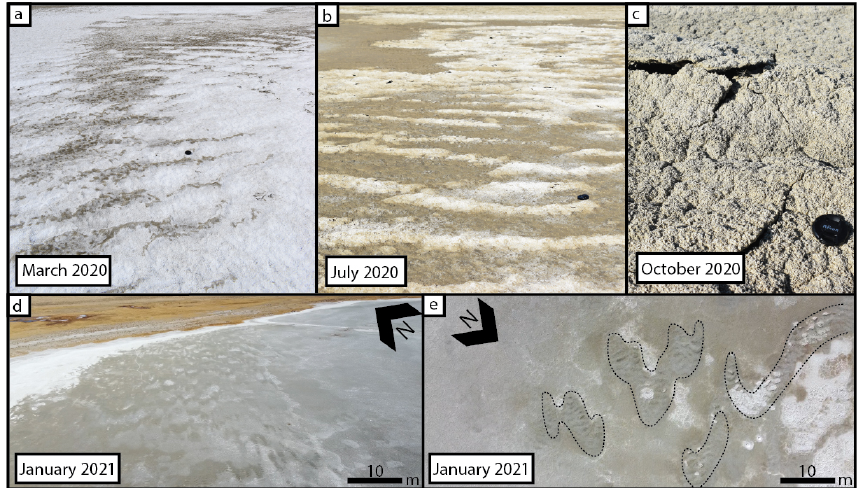
Figure 4. Ripples observed around Deep Springs. (a, b) Ripples seen in Deep Springs during a wet (a) and dry (b) portion of the year. As the playa dries throughout the year, the ripples in the same region of the playa had longer wavelengths. (c) Ripples cracking during the warmest portion of the year. While in this condition, ripples become hollow in their interiors. (d, e) Ripples observed via drone in the far northern end of the playa. Ripples, outlined by dashed lines in (e) , are within an overall crescent shape and are oriented towards the southwest, downwind of the dominant wind direction in Deep Springs. Images (d) and (e) courtesy of Google Earth (© Google Earth 2022).